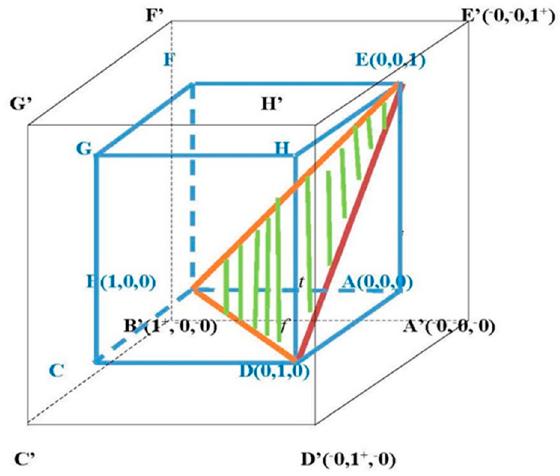
Figure 1. Neutrosophic cube.